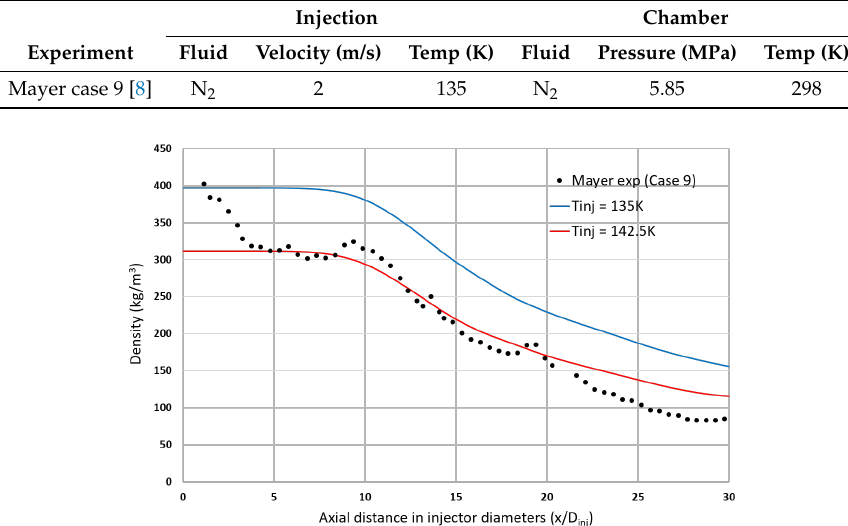
Figure 15. Comparison of solver results with two injection temperatures (Tinj = 135 K and Tinj = 142.5 K) against Mayer’s experimental [8] axial density measurements for case